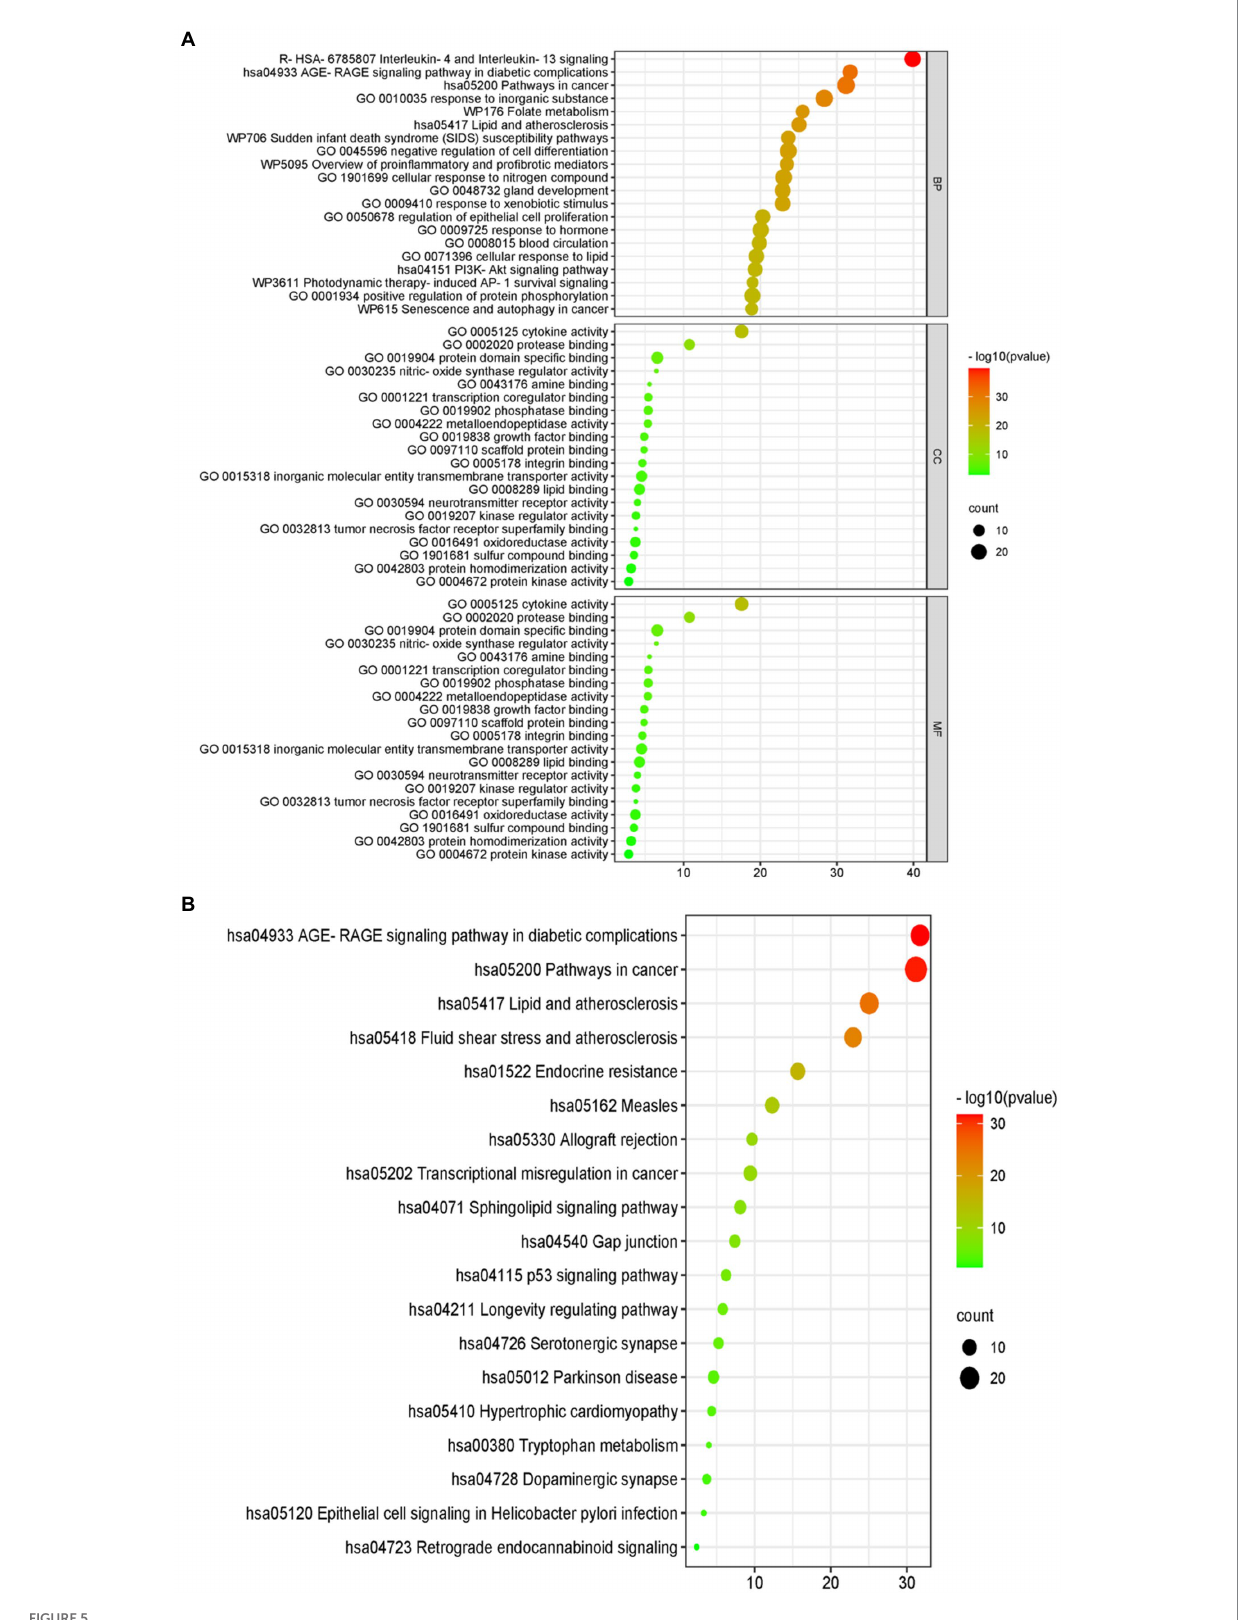
FIGURE 5 Gene ontology (GO) and the Kyoto Encyclopedia of Genes and Genomes (KEGG) analyses. (A) The GO analytic bubble diagram. (B) The KEGG analytic bubble diagram. The size of the circle represents the number of genes enriched in the pathway. The larger the circle, the greater the number of enriched proteins, and the color represents different p